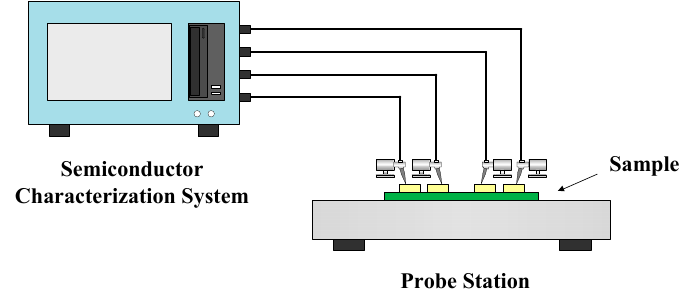
Figure 5. Schematic diagram of the experiment system.